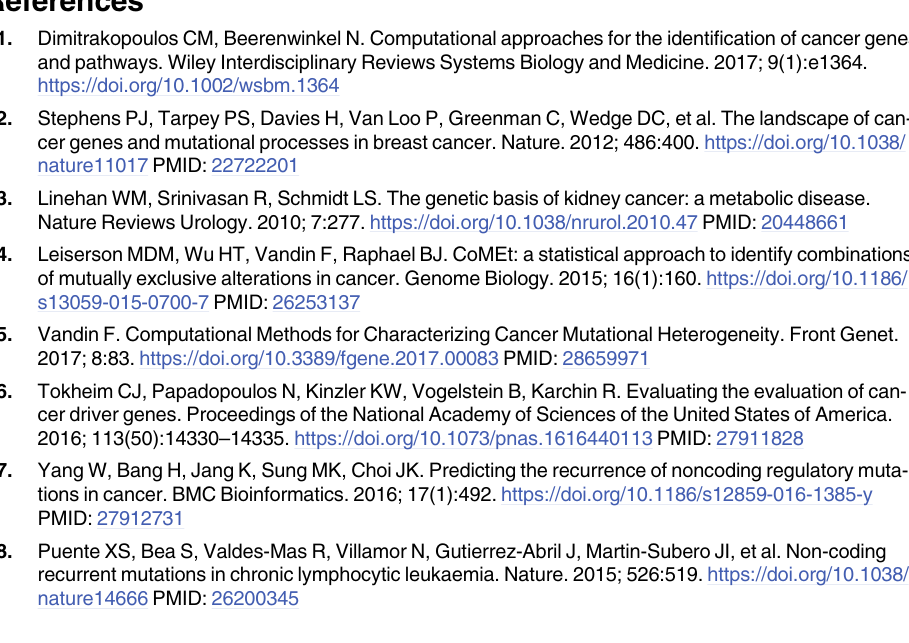
S2 Table. List of coding drivers without mutations. Coding BRCA drivers without mutations predicted by CBNA. S3 Table. List of miRNA drivers. Predicted miRNA BRCA drivers by CBNA. S4 Table. List of validated coding drivers with mutations. Validated coding BRCA drivers with mutations which are specific to the cancer condition